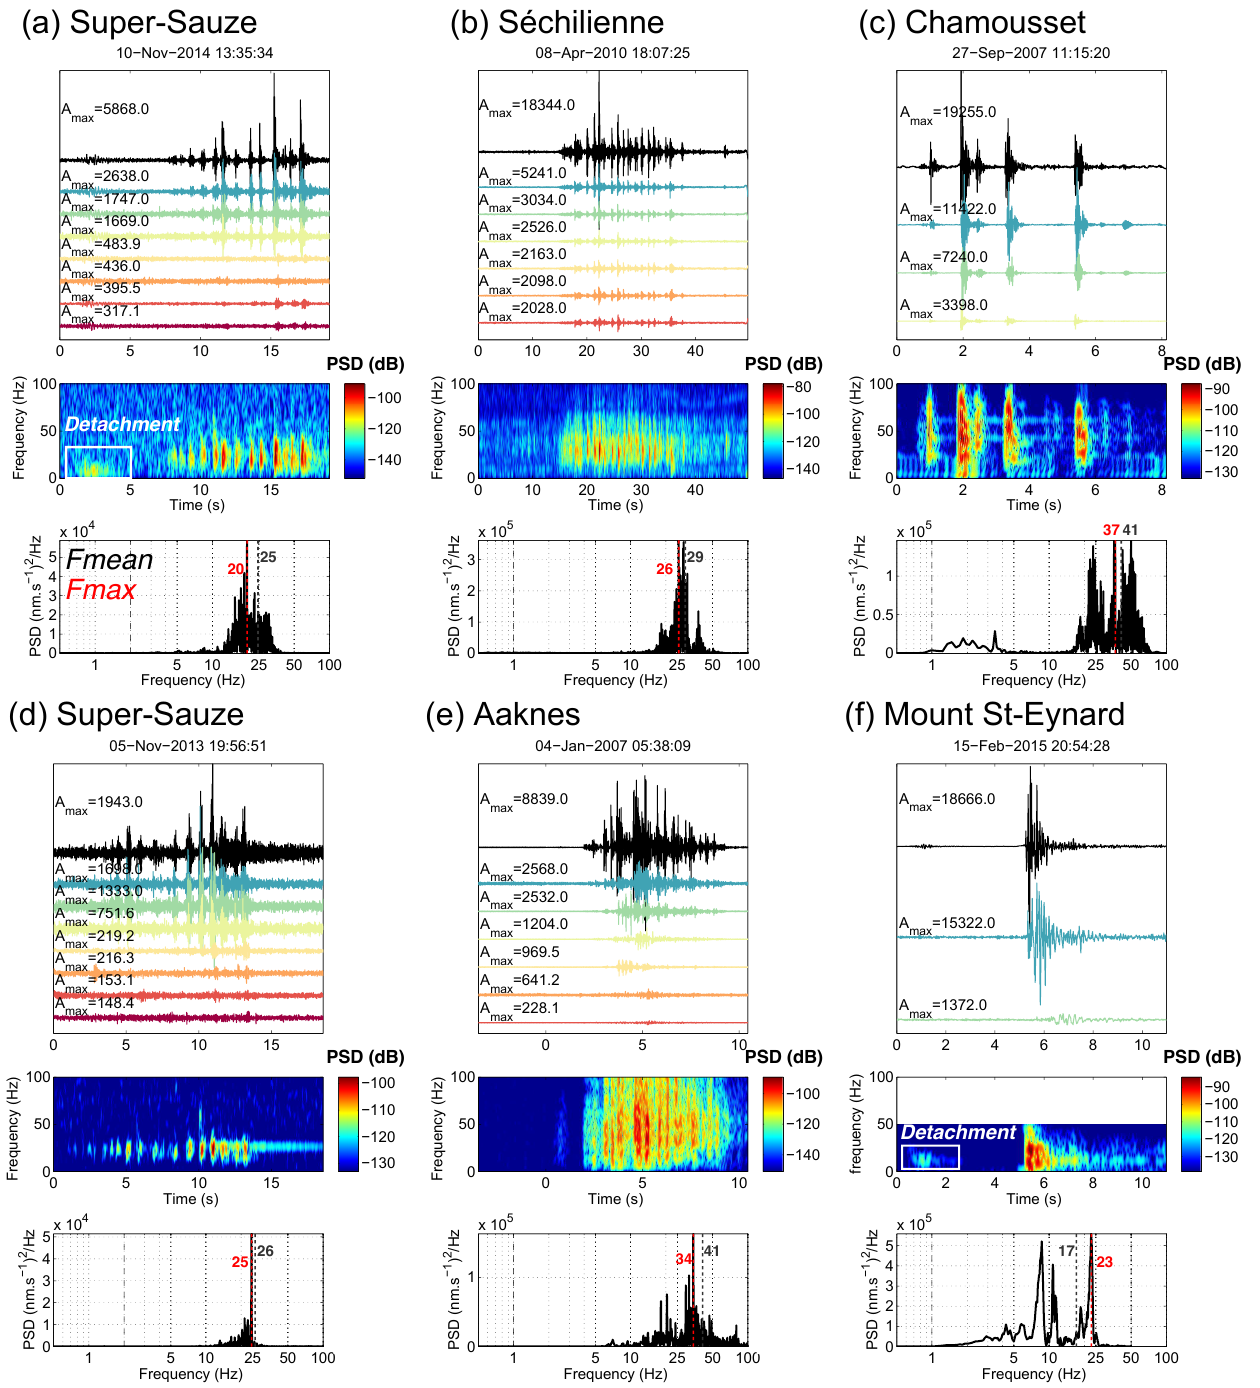
Figure 3. Rockfall events recorded at (a) and (d) Super-Sauze (France; Provost et al., 2017a), (b) at the Séchilienne (France; Helmstetter et al., 2011; RESIF/OMIV, 2015), (c) Chamousset (Levy et al., 2011), (e) Aaknes and (f) Mount Saint-Eynard slopes (Le Roy et al., 2018). See Fig. 2 for a description of the